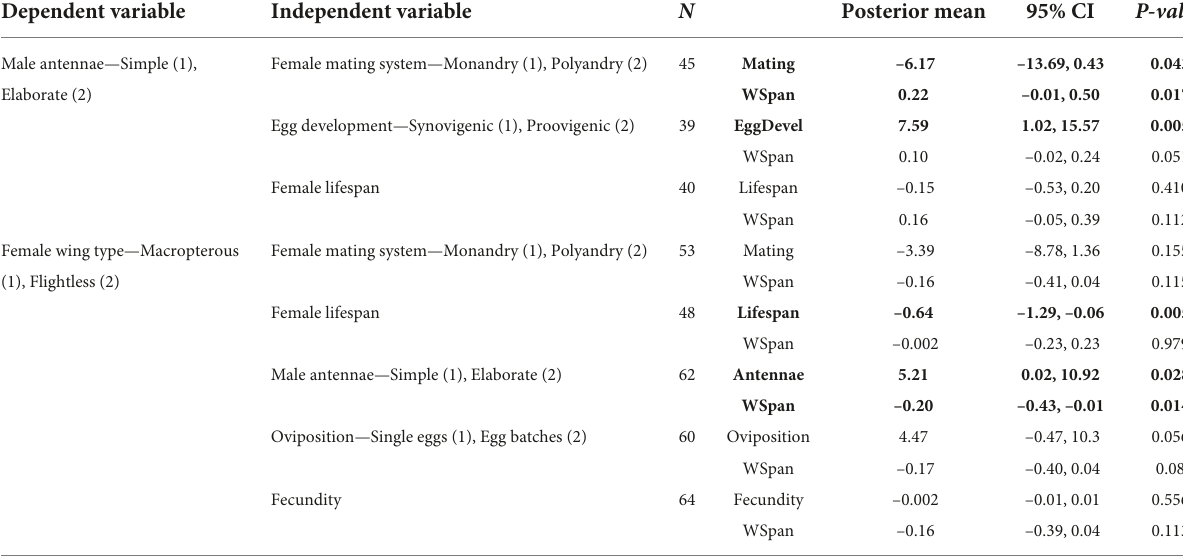
TABLE 2 Results from the MCMCglmm analysis comparing the dependent variable (male antennal type, female wing type) to the independent variable, controlling for body size (male